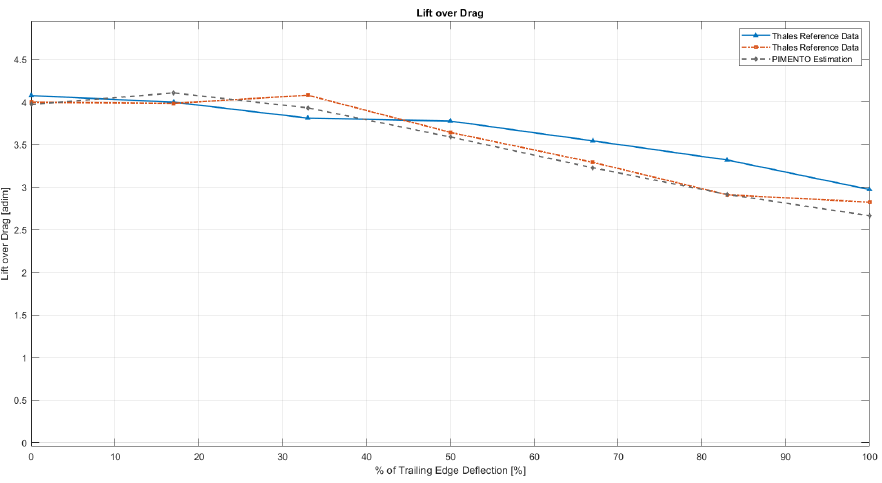
Figure 3. L/D with over different symmetric deflections of the parafoil trailing edge. The reference data of TAS − I are in blue and orange. The PIMENTO data are in